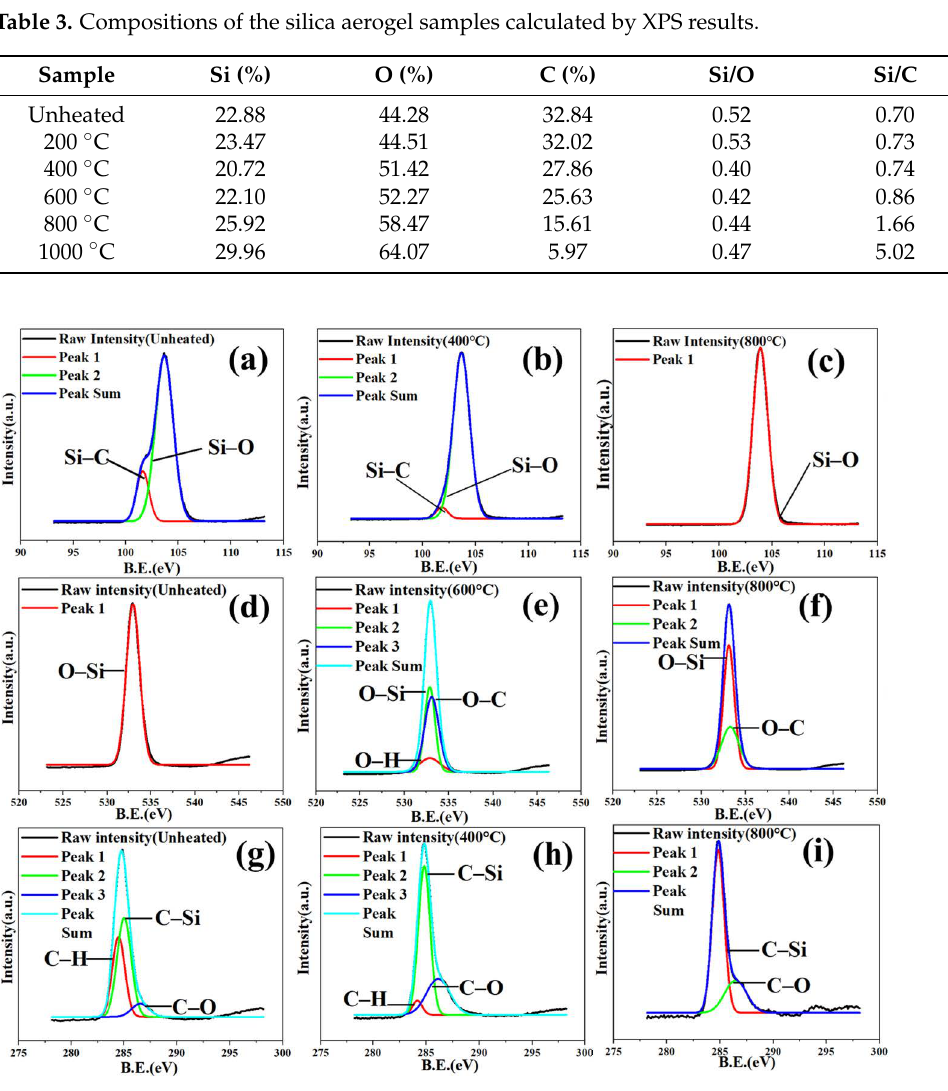
Figure 4. Si 2p spectra of the silica aerogel heat treated at different temperatures: ( a ) Unheated, ( b ) 400 ◦ C and ( c ) 800 ◦ C, respectively. O 1 s spectra of the silica aerogel heat treated at different temperatures: ( d ) Unheated, ( e ) 600 ◦ C, and ( f ) 800 ◦ C, respectively. C 1 s spectra of the silica aerogel heat treated at different temperatures: ( g ) Unheated, ( h ) 400 ◦ C, and ( i ) 800 ◦ C,